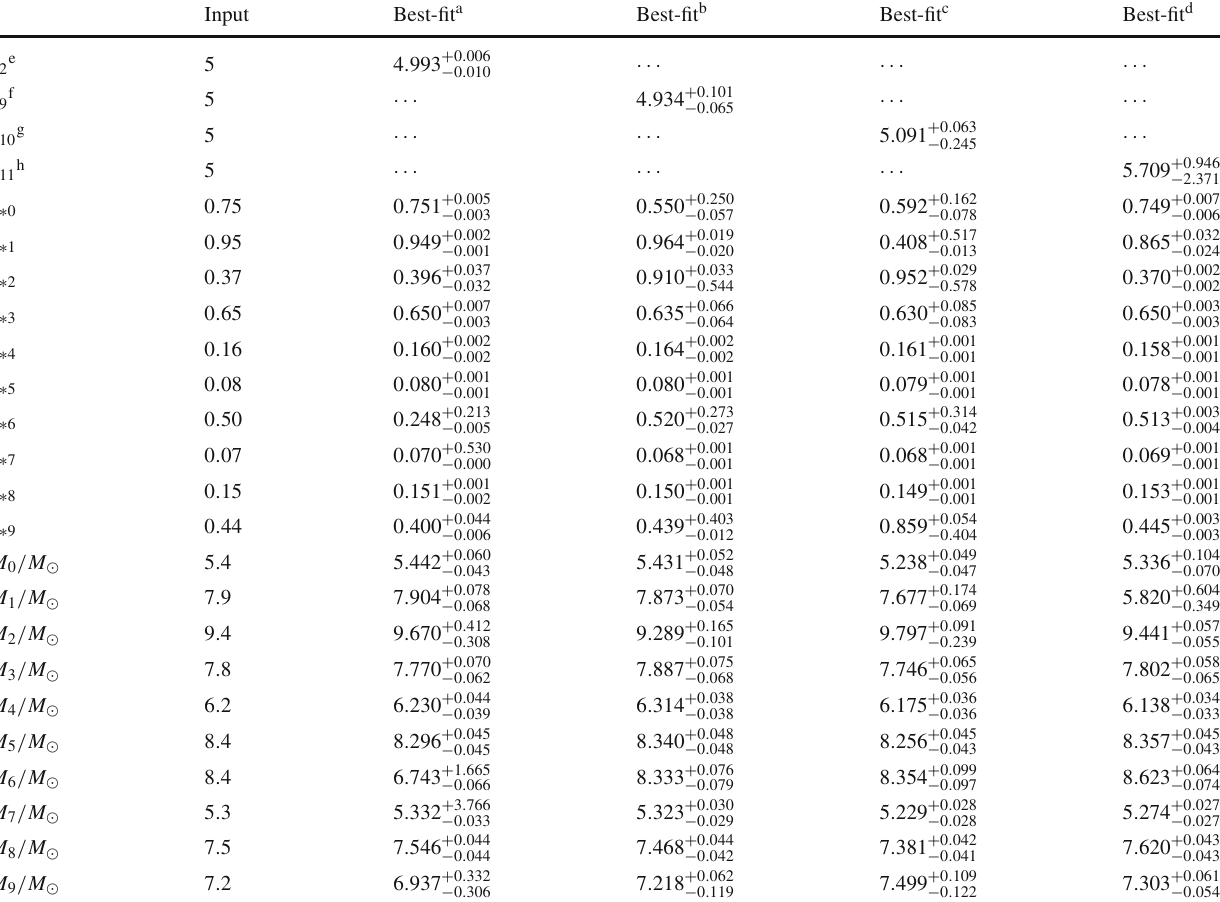
Table 2 Values of the GB parameter inferred from the mock observations generating by assuming a GB metric with only b 2 (cid:6)= 1, or b 9 (cid:6)= 1, or b 10 (cid:6)= 1, or b 11 (cid:6)= 1, but =